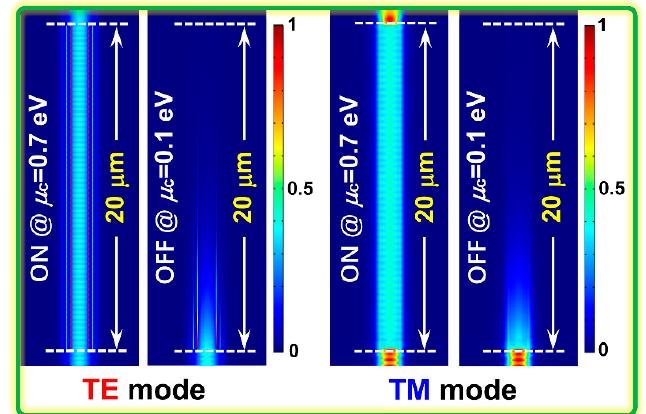
Figure 8. Fabrication tolerance analyses. Transmittance and MD of the proposed modulator as its total ( a ) width W , ( b ) thickness H , and ( c ) length L deviate from their designed values at the “ON” and “OFF” states for both polarizations, where the size deviations of waveguide width and thickness are assumed to be evenly distributed in every hybrid graphene-silicon waveguide layer.